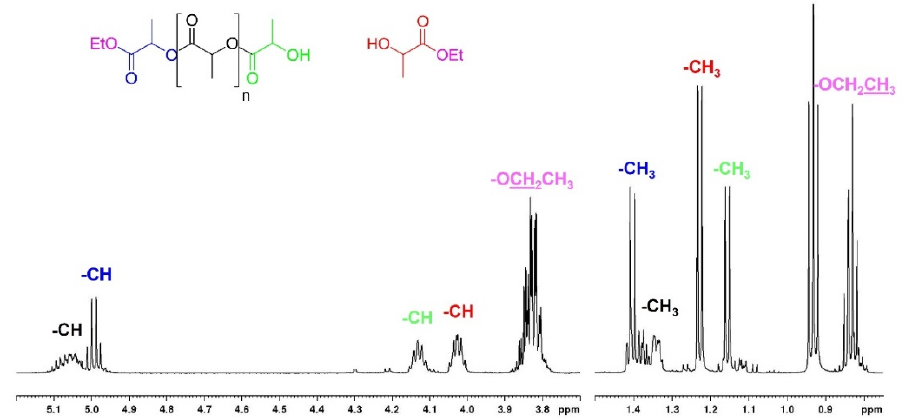
Figure 2. 1 H NMR (CDCl 3 , 400 MHz) monitoring of PLA ethanolysis with assignment of internal (black), chain-end groups (blue and green), and ethyl lactate (red) alkyl protons.